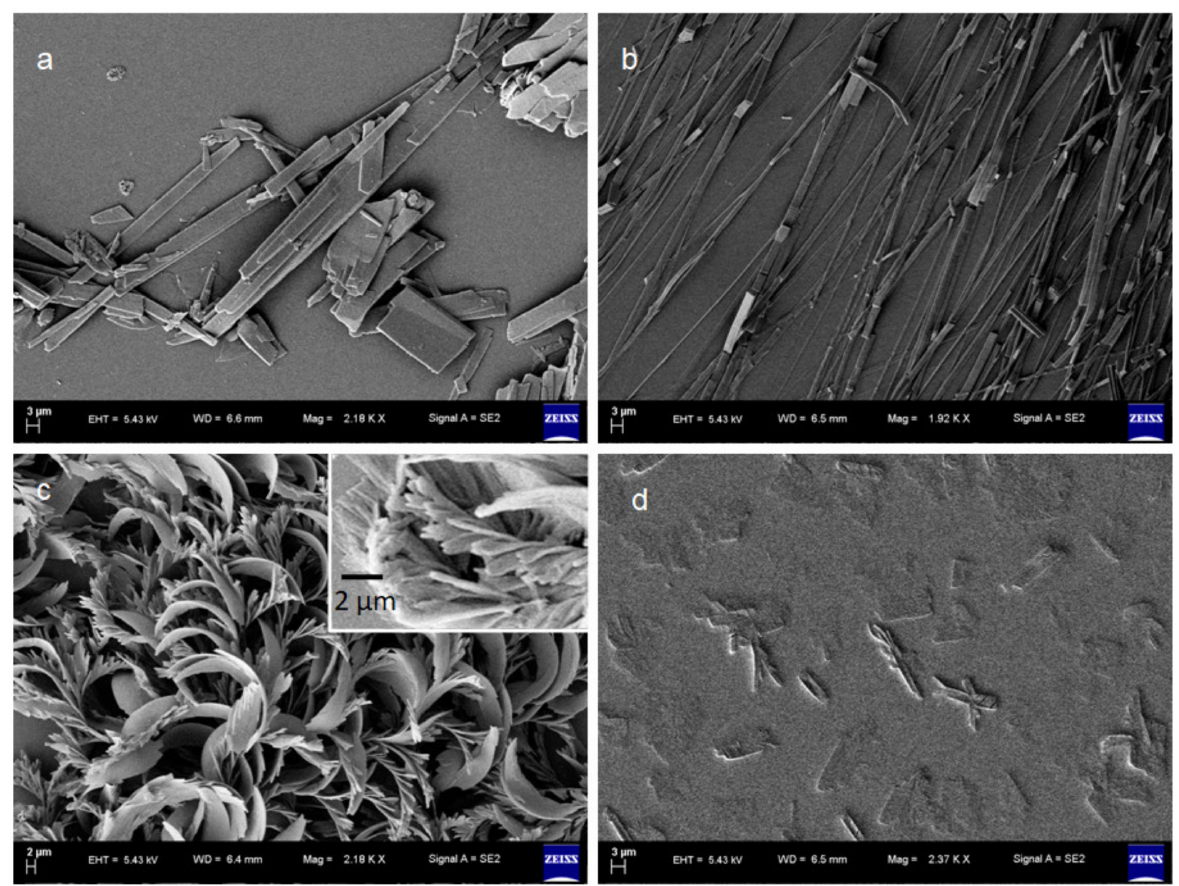
Figure 4. ( a ) The FE-SEM image of only NDI 1 in DMF showing discrete crystals; ( b ) The FE-SEM image of only β -CD in DMF showing several micrometers long rod-like structure; ( c ) The FE-SEM image of NDI 1 and β -CD xerogel showing flake like entangled morphology. Inset: showing the flakes have developed from the assembly of smaller rods; ( d ) The FE-SEM image of NDI 2 and β -CD in DMF